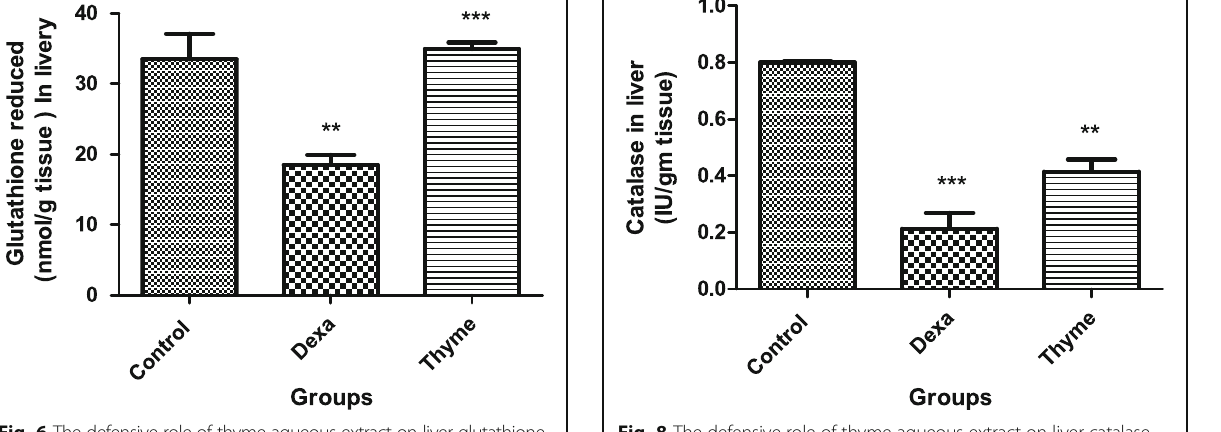
Fig. 6 The defensive role of thyme aqueous extract on liver glutathione level in normal and dexamethasone (DXM)-treated rats. Percentage changes (%) were calculated by comparing normal group with DXM- treated group and pre-treated DXM groups with DXM-treated group